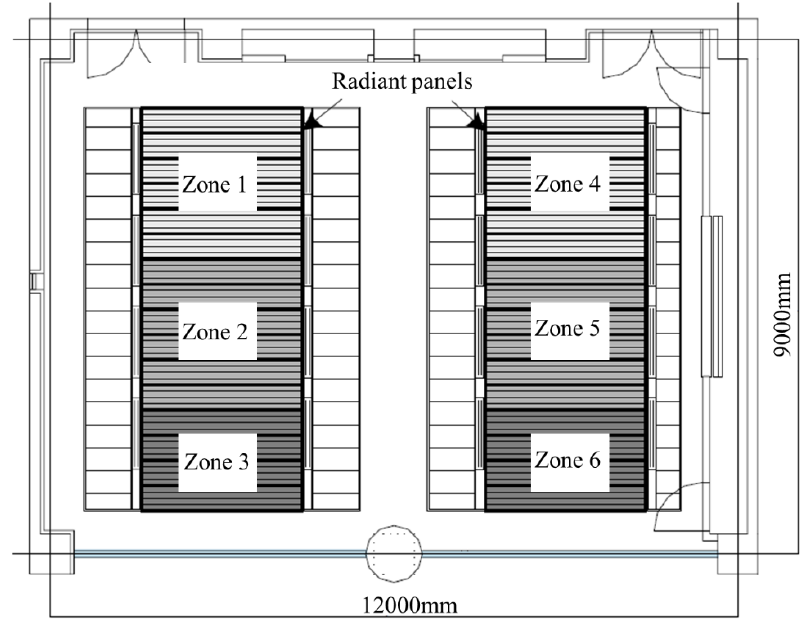
Figure 1. Laboratory floor